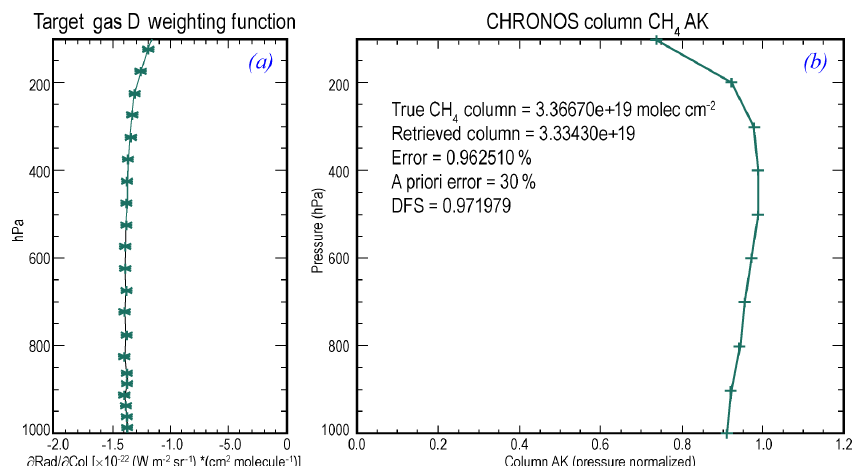
Figure 14. CHRONOS CH 4 D -signal weighting function and retrieval column AK. (a) Sensitivity of the D signal to changes in CH 4 column (Rad (D)/∂ col ) as a function of vertical pressure for a standard midlatitude summer atmosphere with albedo = 0.1, SZA = 0 ◦ and satellite ZA = 40 ◦ . (b) The retrieval column averaging kernel from the corresponding D/A signal ratio and Jacobian. This assumes CHRONOS measurement precision and a priori covariance with 30% diagonal errors and 500hPa correlation length (retrieval was performed on a coarser pressure grid than the weighting function calculations). Since the signal source is solar reflectance, the response is nearly uniform vertically with DFS close to 1.